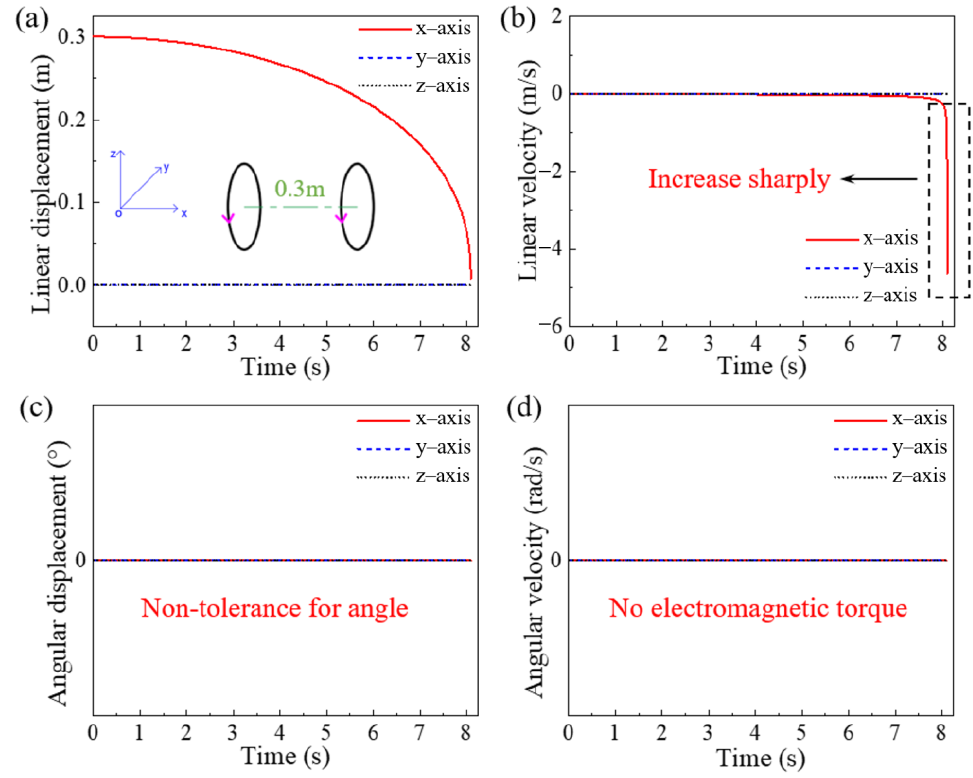
Figure 5. The linear displacement ( a ), linear velocity ( b ), angular displacement ( c ), and the angular velocity ( d ) of the subsatellite during the docking process with non-tolerance.